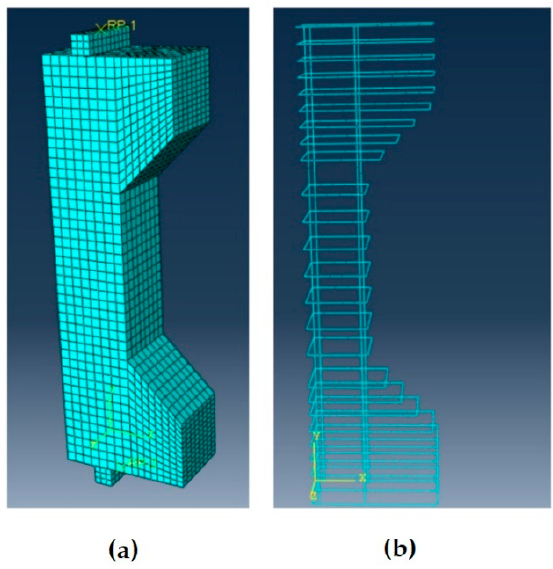
Figure 6. ( a ) Mesh for the square cross section of 180 mm × 180 mm × 1100 mm; ( b ) geometry of the cage.